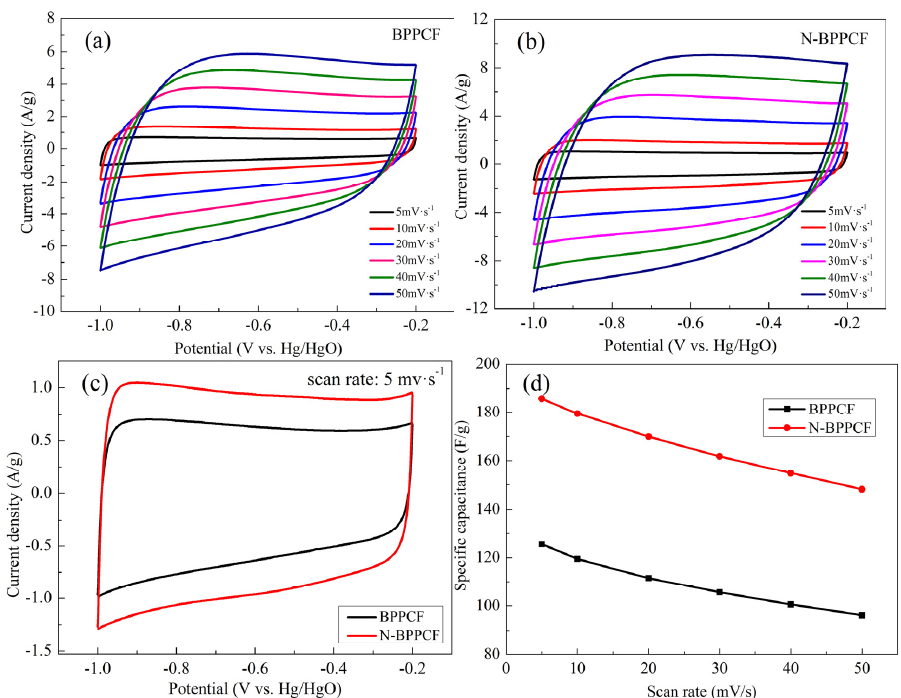
Figure 5. Cyclic voltammogram (CV) curves for ( a ) BPPCF and ( b ) N-BPPCF in 6 M KOH at different scan rates. ( c ) CV curves of the samples at a scan rate of 5 mV/s. ( d ) Specific capacitance calculated according to CVs.